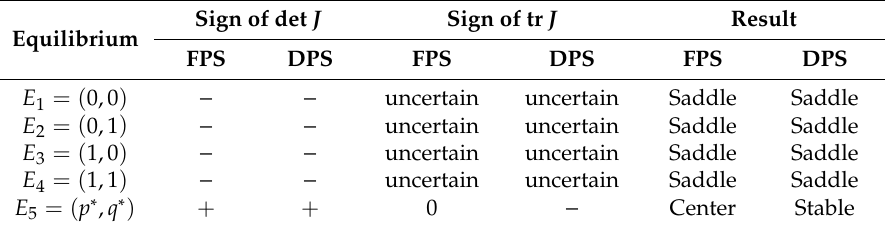
Table 5. Situation 3: local stability of